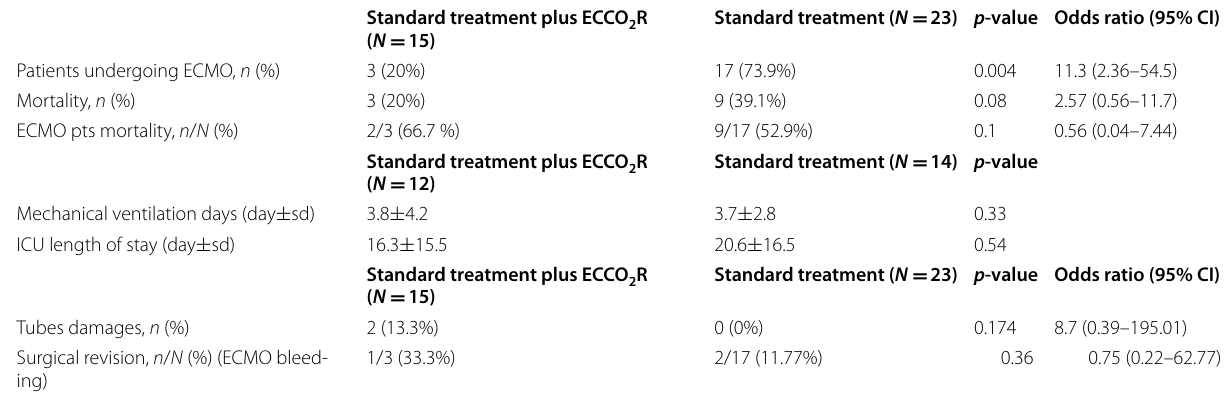
In the upper side of the box, the rate of ECMO treatment in the standard treatment and standard treatment plus ECCO 2 R groups; in the middle side of the box, the mechanical ventilation days and postoperative ICU length of stay in the 2 groups (patients who had ECMO treatment were excluded); in the lower side of the box, the complications occurred in the 2